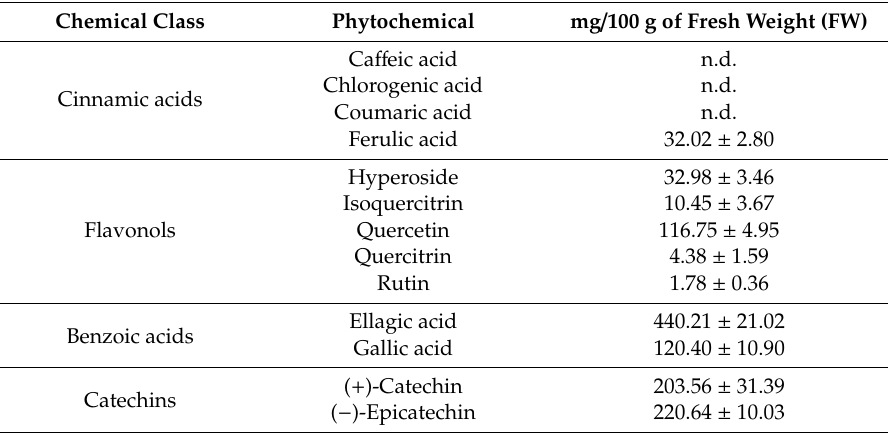
Table 1. Main phytochemicals in T. tomentosa